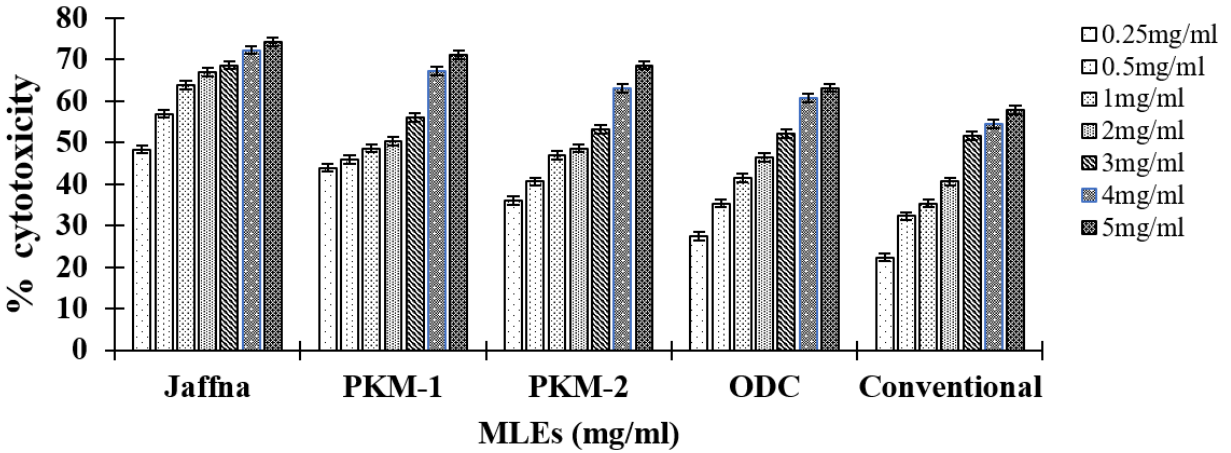
Figure 3. Graphical representation of MTT assay using MLEs.